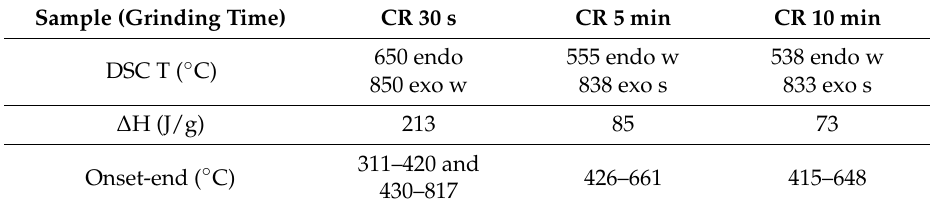
Table 4. Main peak temperatures in DSC curves and ∆ H dehy for crocidolite (CR) after grinding for 30 s, 5 min and 10 min, w = weak, s = strong, endo = endothermic, exo = exothermic. The area under the endothermic peak ( ∆ H dehy ) is delimited in the range onset-end.